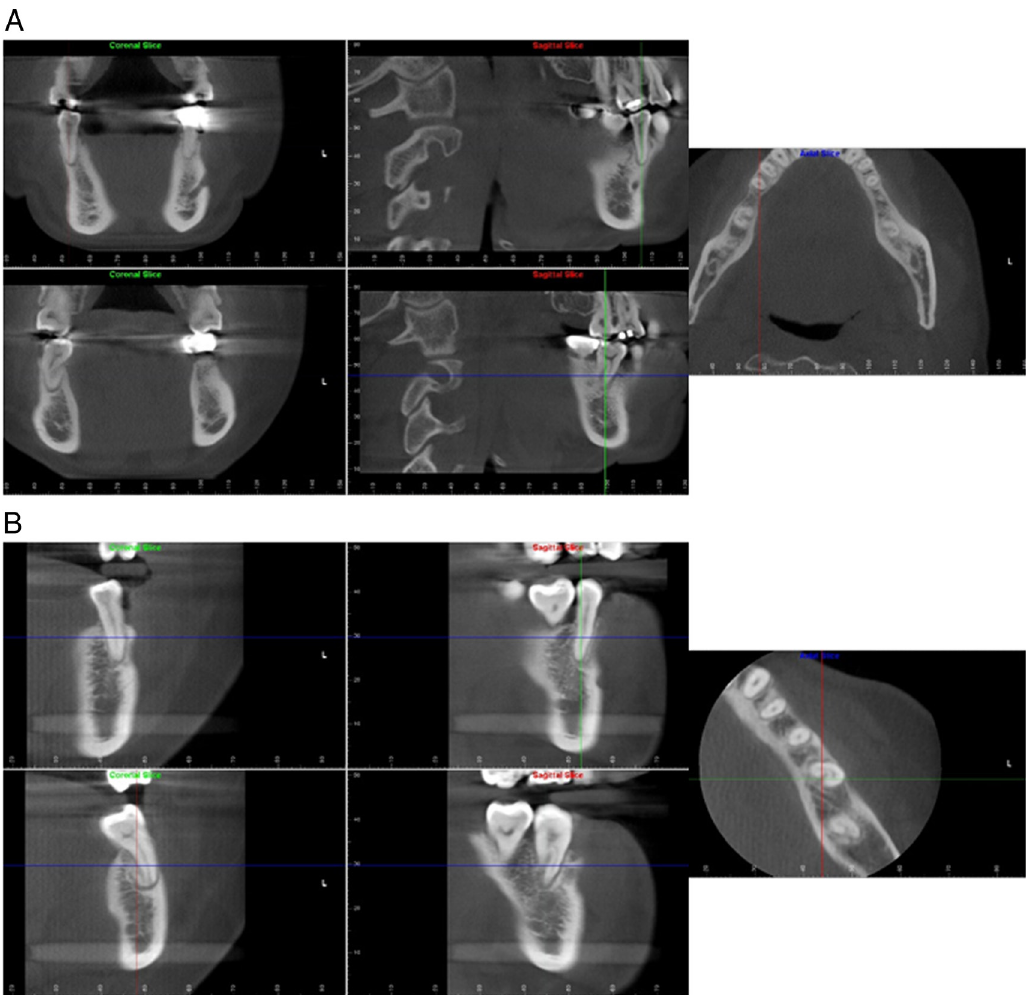
Figure 3. Post-treatment CBCT: (A) In Case 1, the mandibular right second premolar had minor buccal dehiscences. However, the mandibular right second molar had no areas of bone dehiscence/fenestration. (B) In Case 2, the mandibular left second premolar had no areas of bone dehiscence/fenestration and had favourable alveolar continuity over the mandibular left protracted molars in the axial direction. However, thin bone covering of the buccal surface was noted in the coronal section and small root resorption lacunae were observed in the mesial aspect of the root surface in the molar sagittal view.